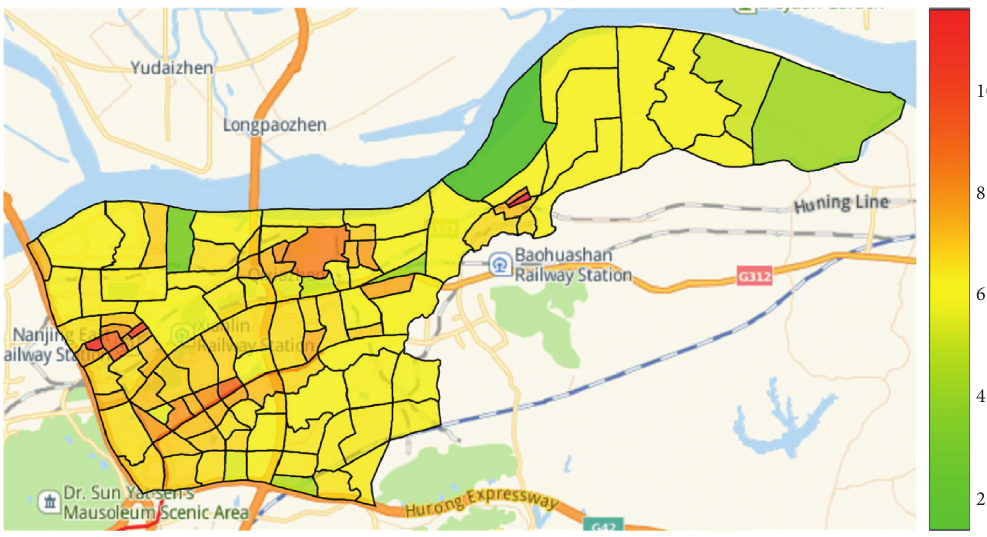
Figure 4: TPIs of the regions in the Xianlin district.